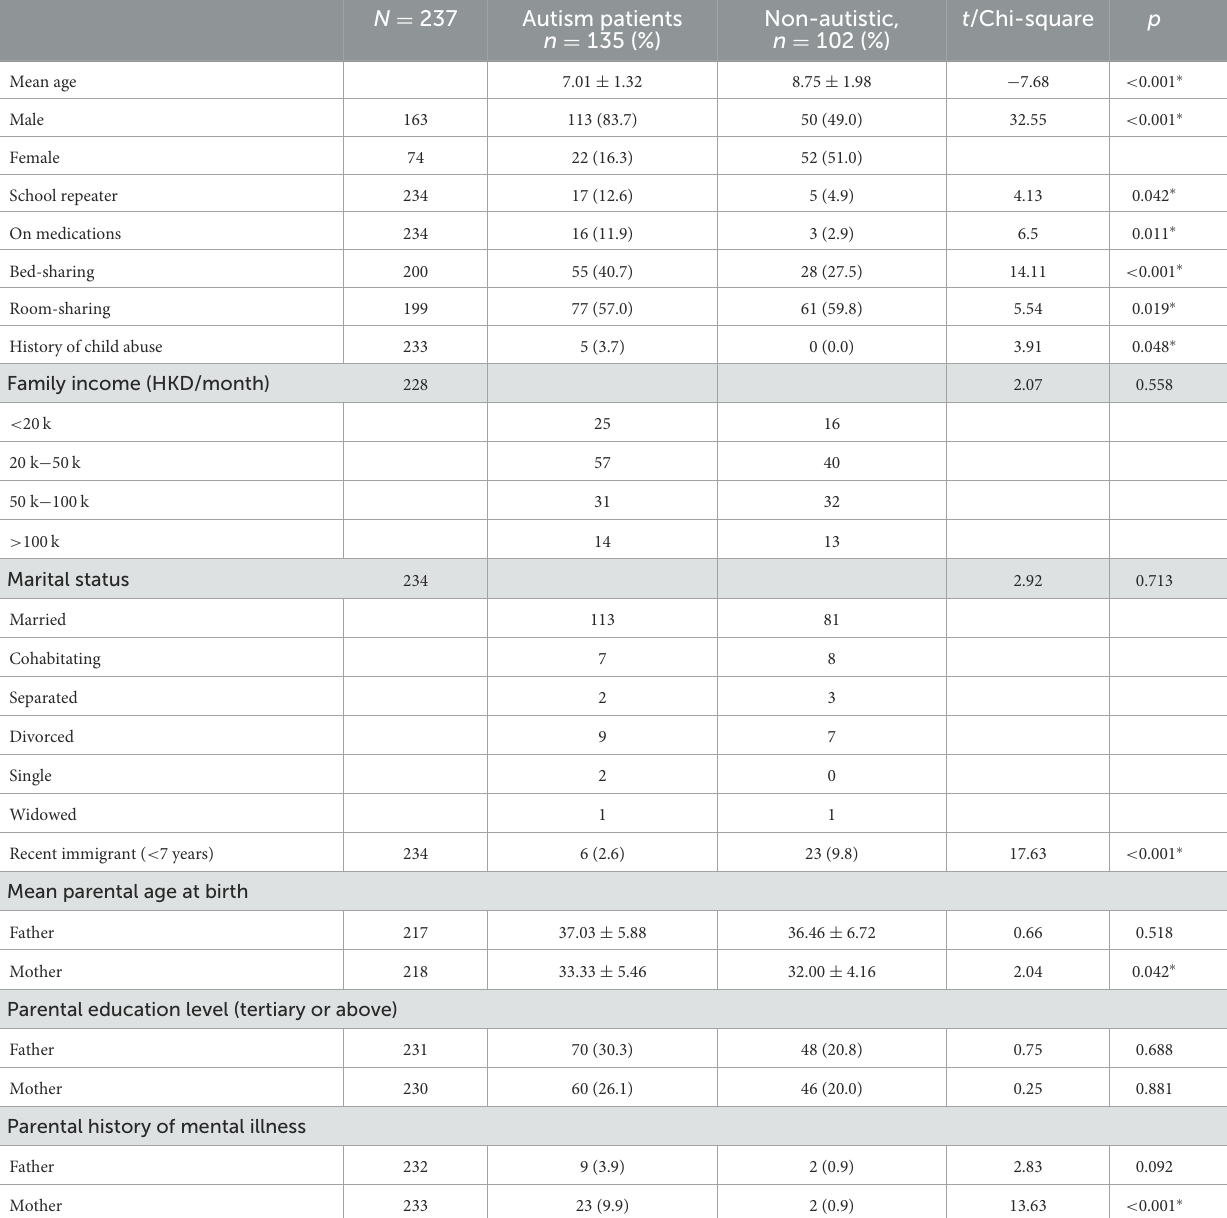
TABLE 1 Characteristics of subjects and their parents in autism and non-autistic group.